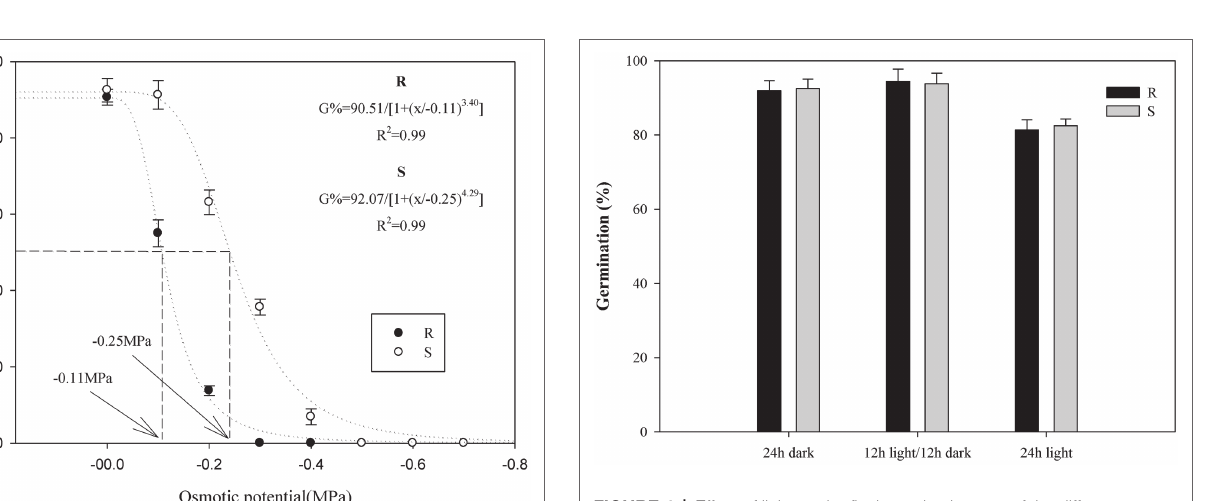
FIGURE 4 | Effect of light on the final germination rate of the different Polypogon fugax populations. Error bars represent standard error of the means. Values represent the mean of eight replications with 40 seeds per replication. The abbreviations R and S represent for the resistant and sensitive P. fugax populations, respectively.